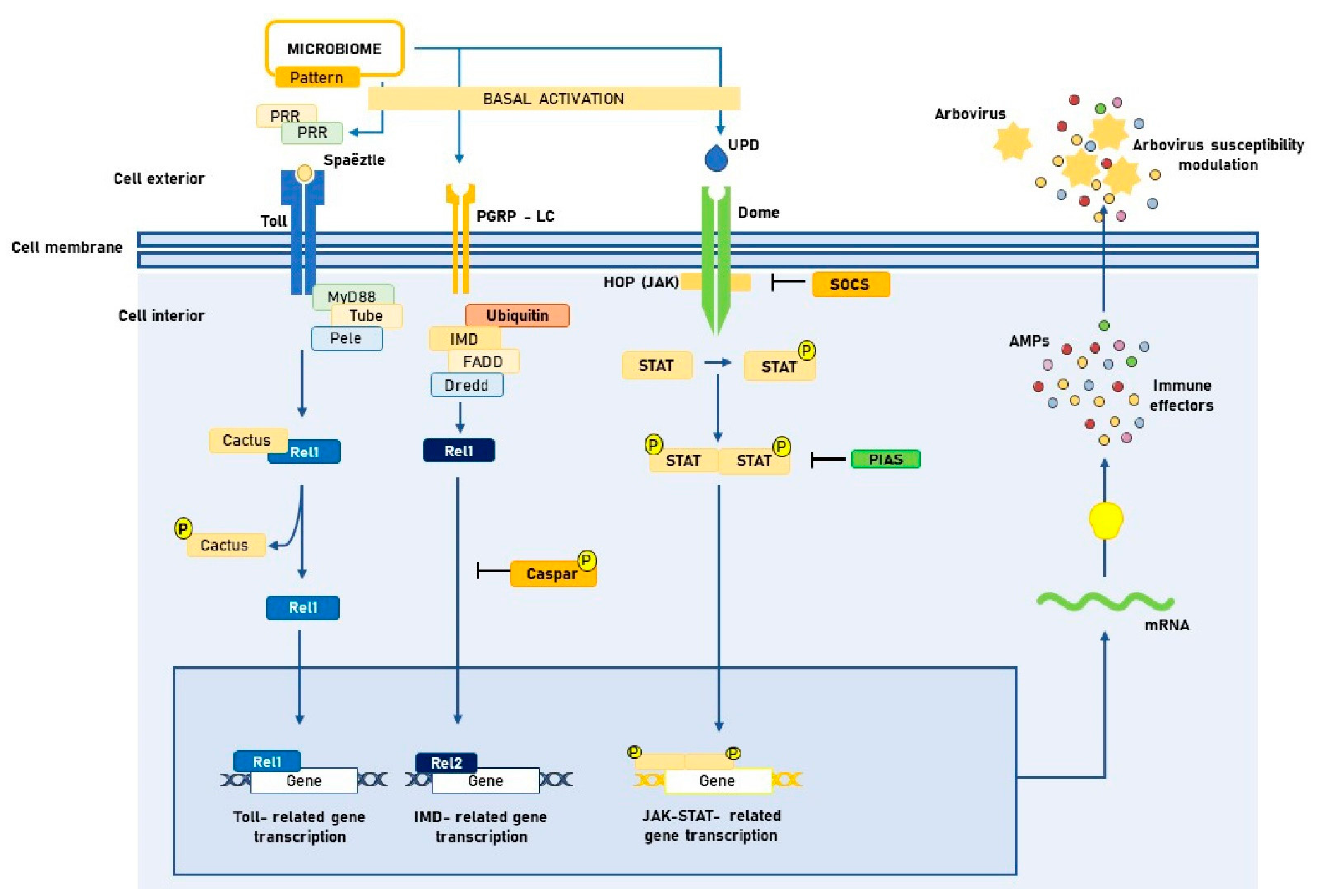
Figure 1. Tripartite interaction between Aedes spp . midgut microbiota, innate immune signaling pathways and arboviruses . PRR: Pa tt ern recognition receptors. PAMP: Pathogen-associated molecular pa tt erns. JAK: Janus kinase. STAT: Signal transducers and activators of transcription. UPD: Unpaired peptide ligand. PGRP-LC: Peptidoglycan recognition proteins. AMP: Antimicrobial peptide. FADD: Fas-associated death domain. SOCS: Suppressors of cytokine signaling. PIAS: Protein inhibitor of activated STAT. IMD: Immune de fi ciency. Created with Microsoft PowerPoint, version 16.16.24.